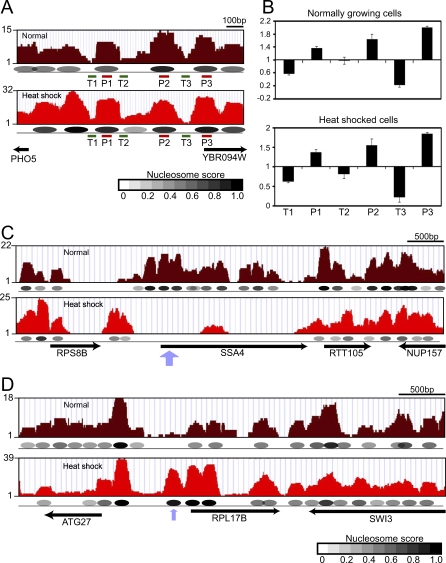
Ultra-High–Throughput Sequencing Recapitulates In Vivo Nucleosome Positions(A) Detailed view of the PHO5 locus showing the raw sequence reads (brown and red profiles). The nucleosome positions calculated using our analysis algorithm are shown as ovals, shaded according to their nucleosome score as indicated. The positions of the amplicons used for qPCR analysis are marked as red (peaks) and green (troughs) lines below. The black arrows indicate the positions of genes in that region.(B) qPCR verification of the three nucleosome peaks and three troughs identified by sequencing confirm that their positions remain the same before and after heat shock.(C) The heat-shock–induced SSA4 gene and flanking regions, showing that nucleosomes are displaced specifically at the SSA4 promoter and coding region after heat shock (thick purple arrow).(D) The heat-shock–repressed ribosomal protein gene RPL17B and flanking regions, showing that a single positioned nucleosome appears after heat shock specifically at the RPL17B promoter (thin purple arrow). The nucleosome positions calculated using our analysis algorithm are indicated as in (A).